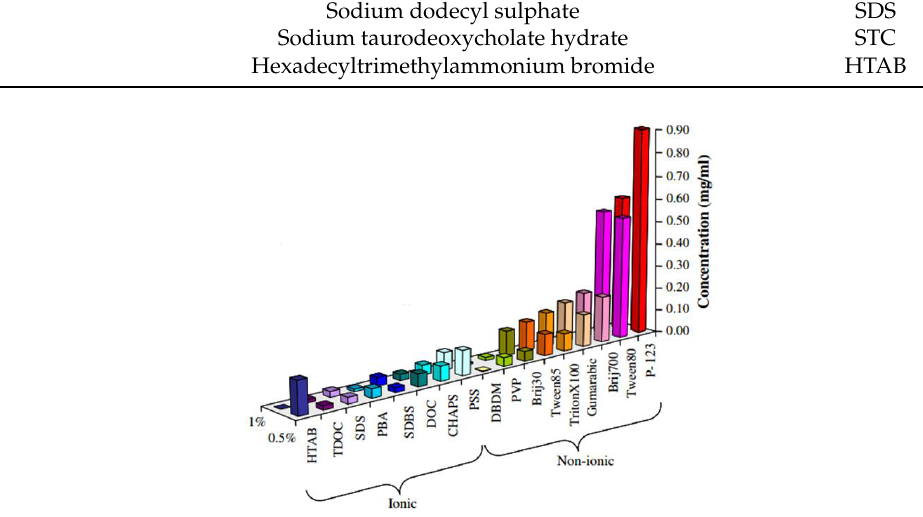
Figure 8. Concentration of graphene in aqueous dispersions achieved by the use of different surfactants (surfactant concentrations: 0.5% and 1.0% wt./vol.) [116]. (Reproduced from [116] with permission; Copyright 2011 Elsevier).